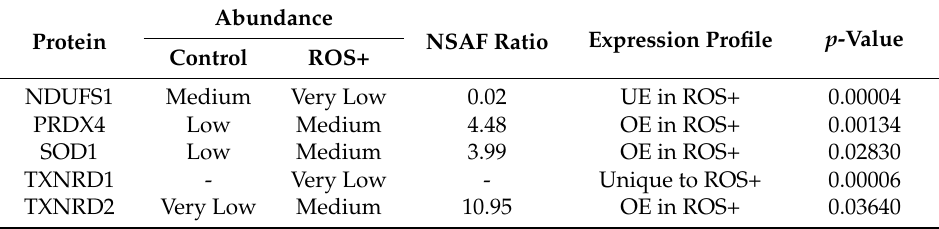
Table 3. Proteomic data of the differentially expressed proteins identified in spermatozoa samples from fertile donors from control and ROS+ groups, selected for validation by Western blot. Abundance Protein NSAF Ratio Expression Profile p -Value Control ROS+ NDUFS1 Medium Very Low 0.02 UE in ROS+ 0.00004 PRDX4 Low Medium 4.48 OE in ROS+ 0.00134 SOD1 Low Medium 3.99 OE in ROS+ 0.02830 TXNRD1 - Very Low - Unique to ROS+ 0.00006 TXNRD2 Very Low Medium 10.95 OE in ROS+